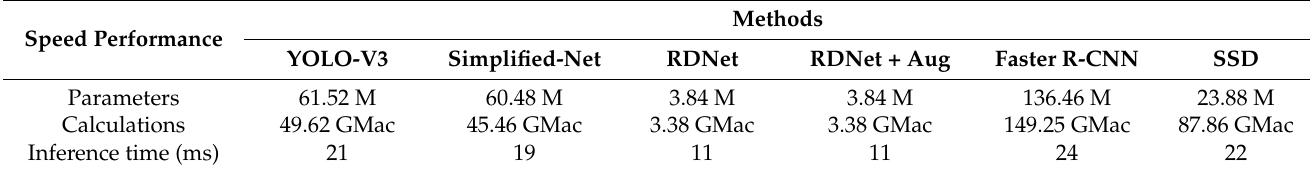
Table 12. Parameters, calculations and inference time of different